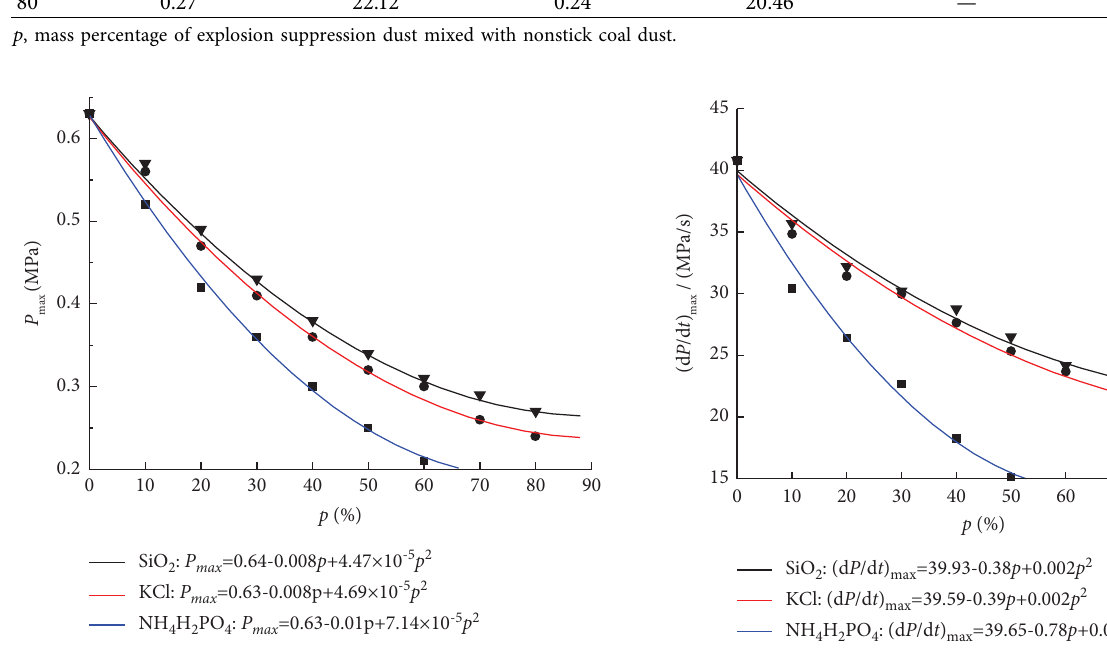
Figure 8: Inhibition efect of an explosion suppressant on maxi- mum pressure rise rate of